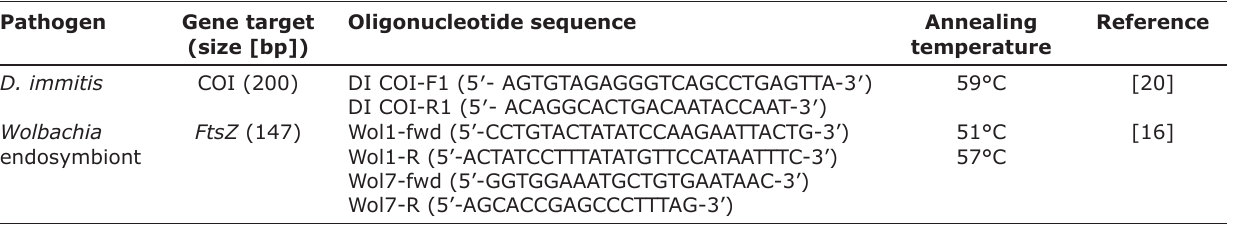
Table-1: Oligonucleotide primers used to detect D. immitis and Wolbachia endosymbiont in blood samples from cats.